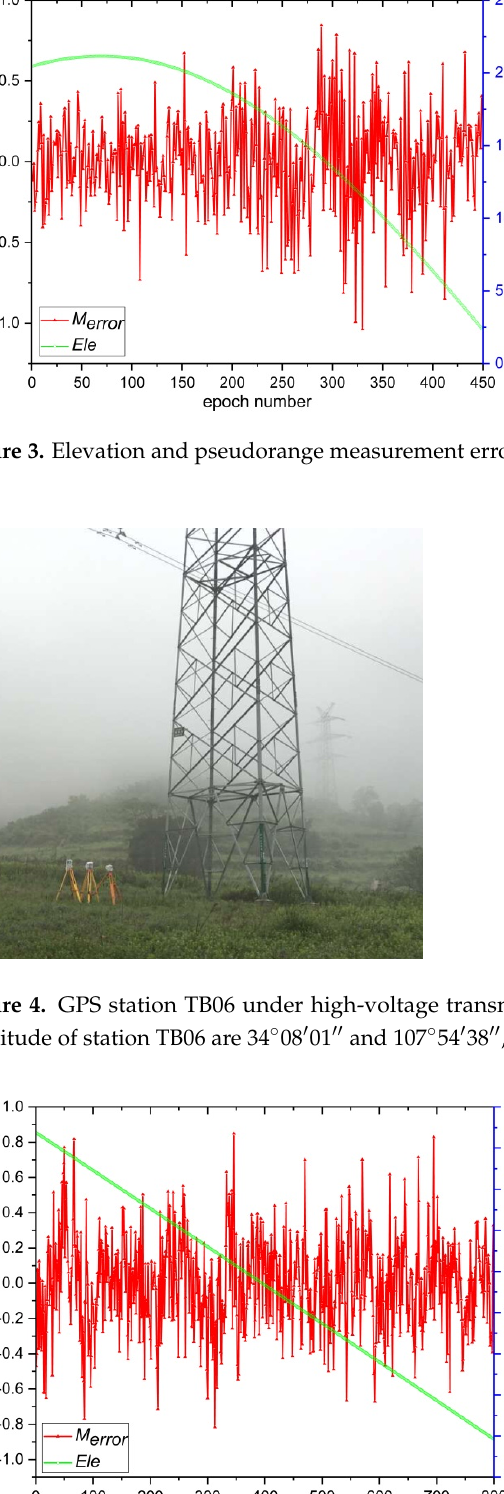
Figure 5. Elevation and pseudorange measurement error sequence of satellite G03.